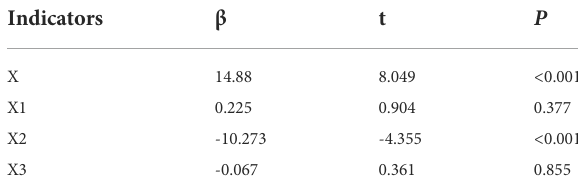
TABLE3Impactoftheimplementationoftheexpertconsensusonthe prevalence of